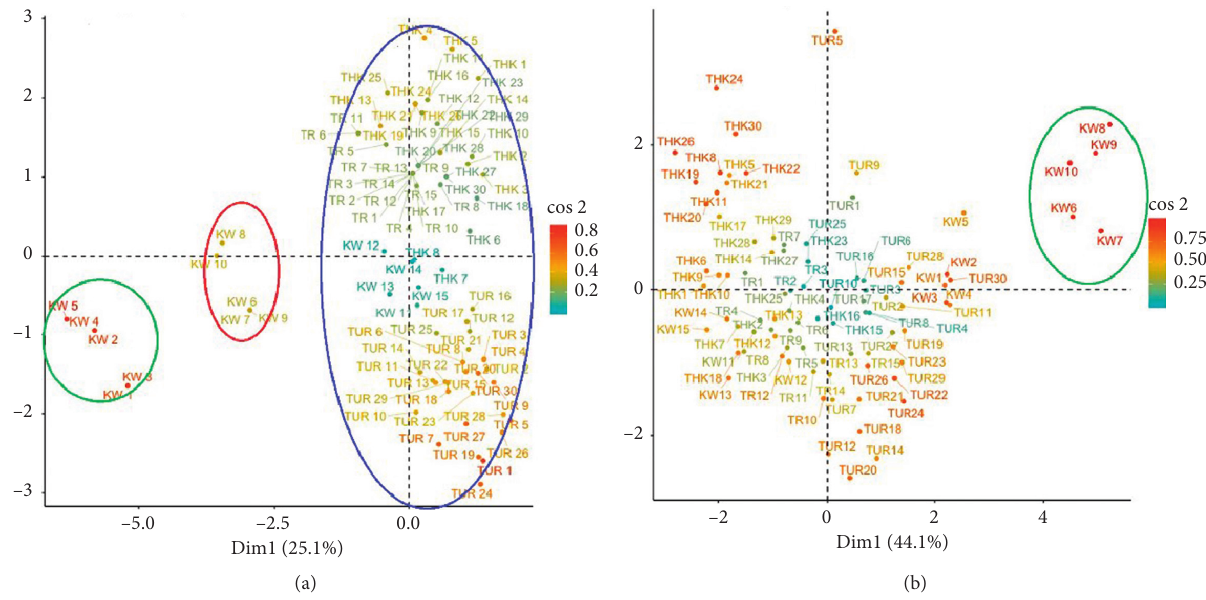
Figure 7: Individual accessions’ PCA for qualitative and quantitative traits in H. compressa in Kenya. (a) Individuals’ PCA using qualitative traits showing three clusters. (b) Individuals’ PCA using quantitative traits showing two major clusters. KW: Kwale, THK: Tharaka Nithi, TR: Tana River, and TUR: